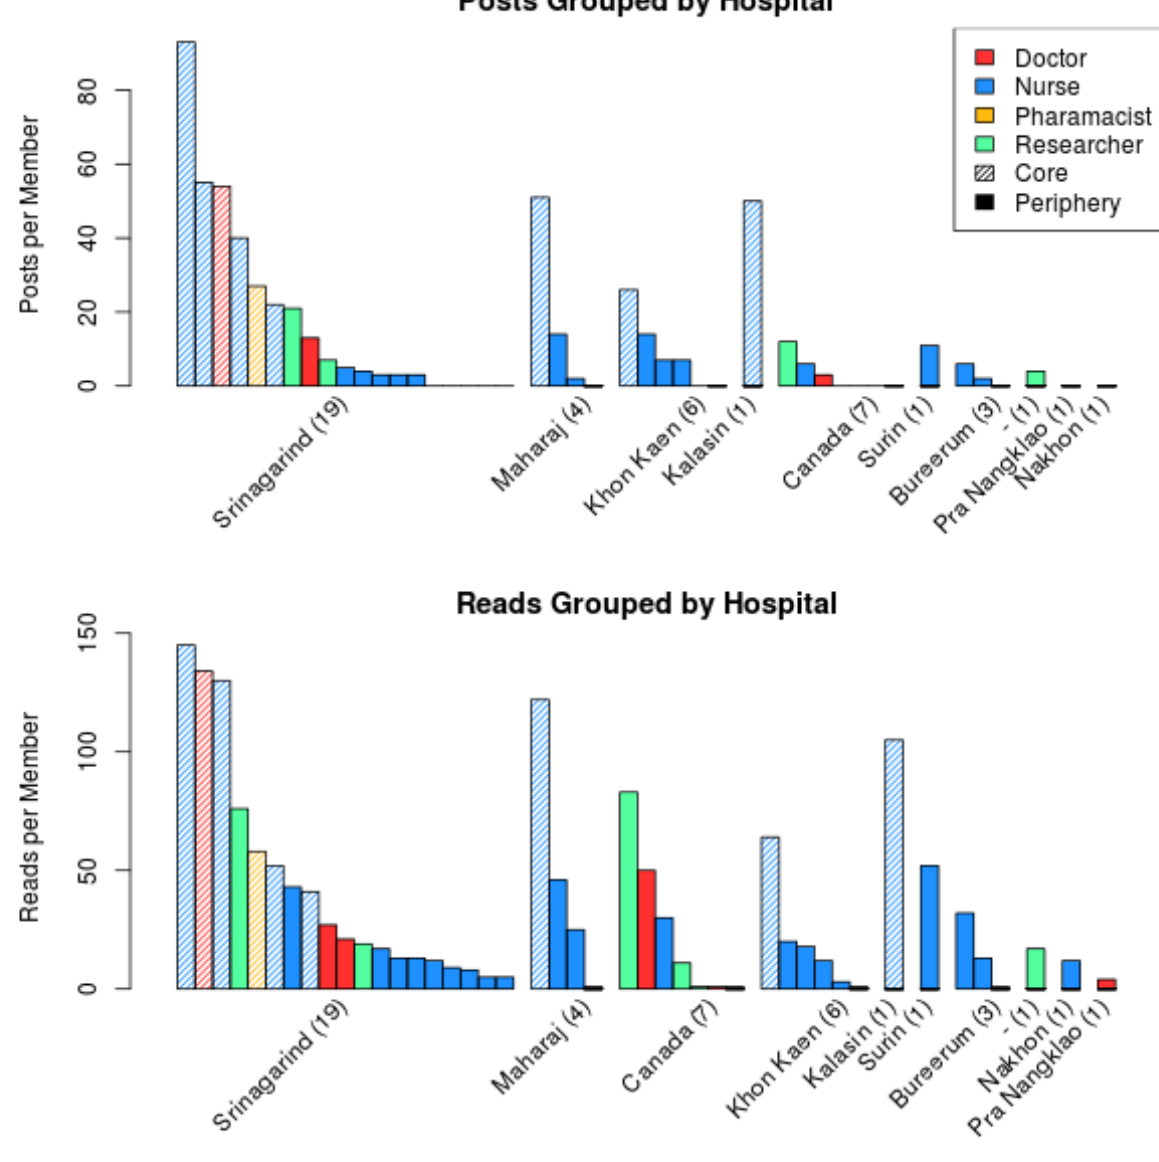
Figure 4. The number of posts and reads, grouped by hospital, with the number of community members in each group denoted within the brackets. Each bar within a hospital represents an individual member. The colour of the bar is an indication of their occupation and the shading on the bar indicates if they are a member of the core or not (see Table